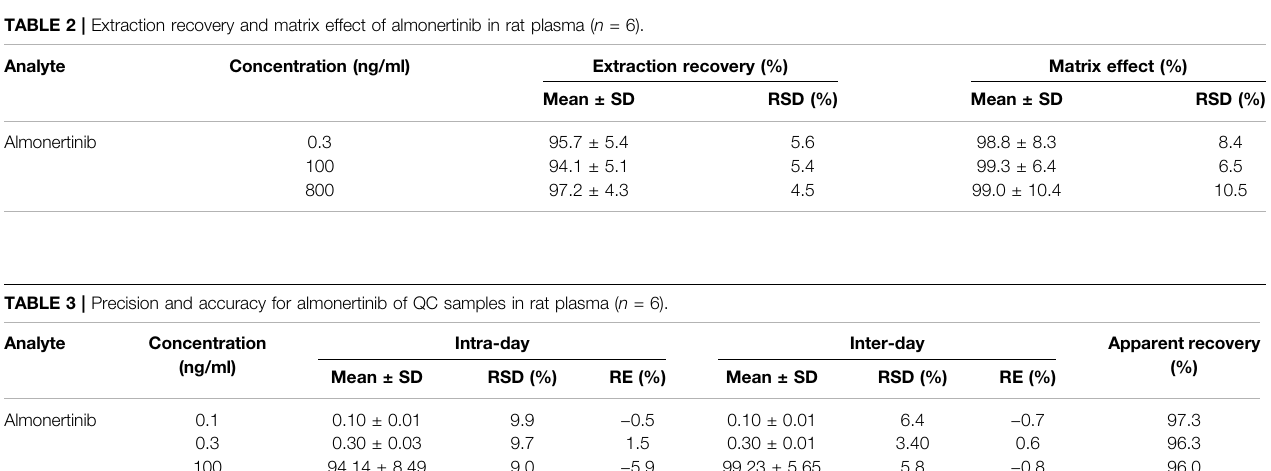
TABLE 2 | Extraction recovery and matrix effect of almonertinib in rat plasma ( n = 6). Analyte Concentration (ng/ml)